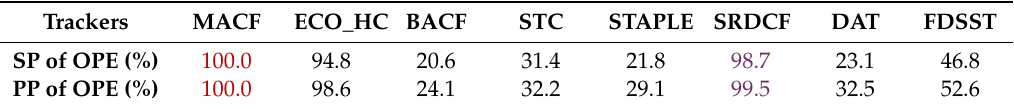
Table 8. The Success Plots (SP) and Precision Plots (PP) of One Pass Evaluation (OPE) for the proposed MACF and the other 7 top trackers on the UAV video. The best results are in red and the second results are in